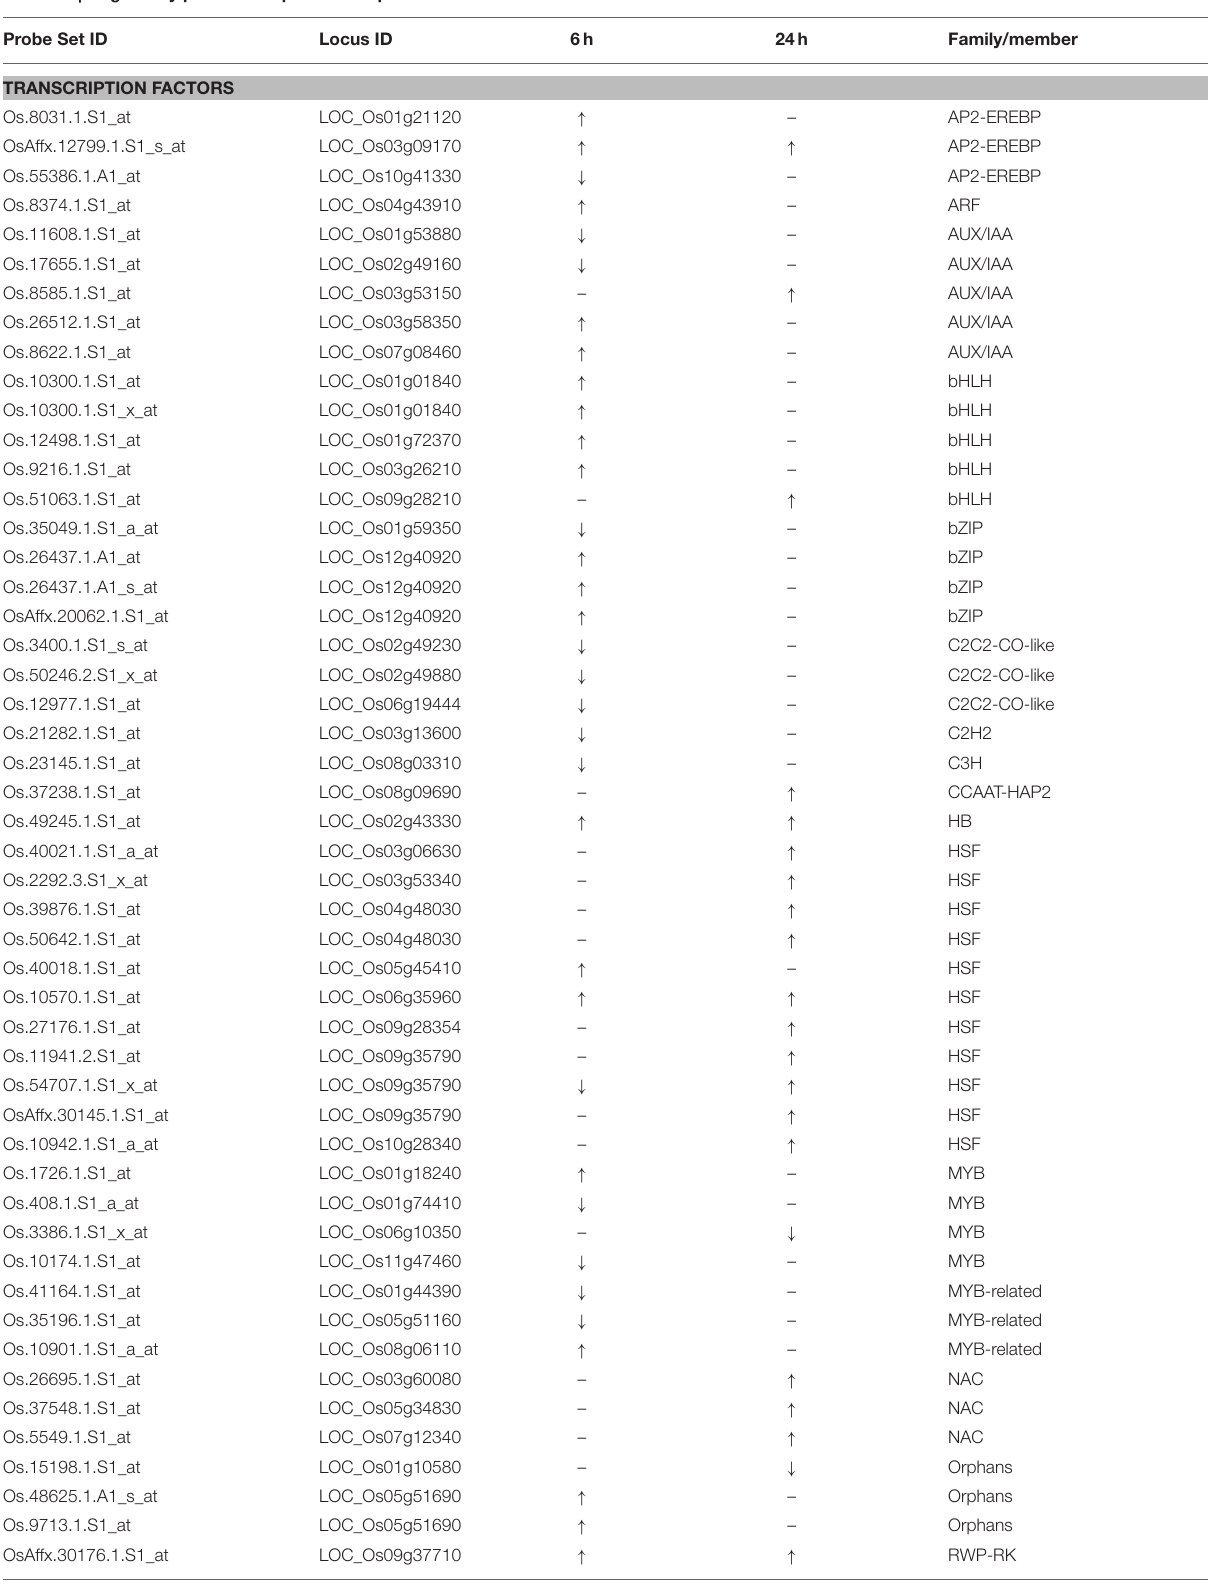
TABLE 2 | Regulatory proteins responded to quinclorac